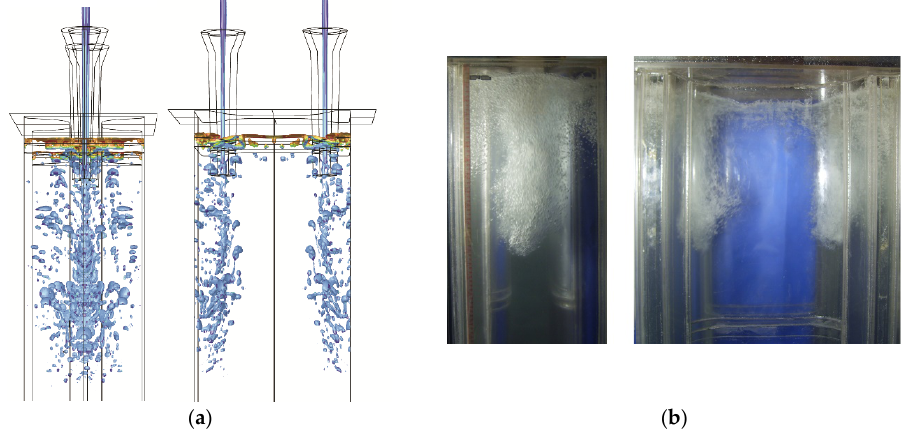
Figure 7. Air bubbles and bath level oscillation of mathematical modeling ( a ) and physical modeling ( b ).